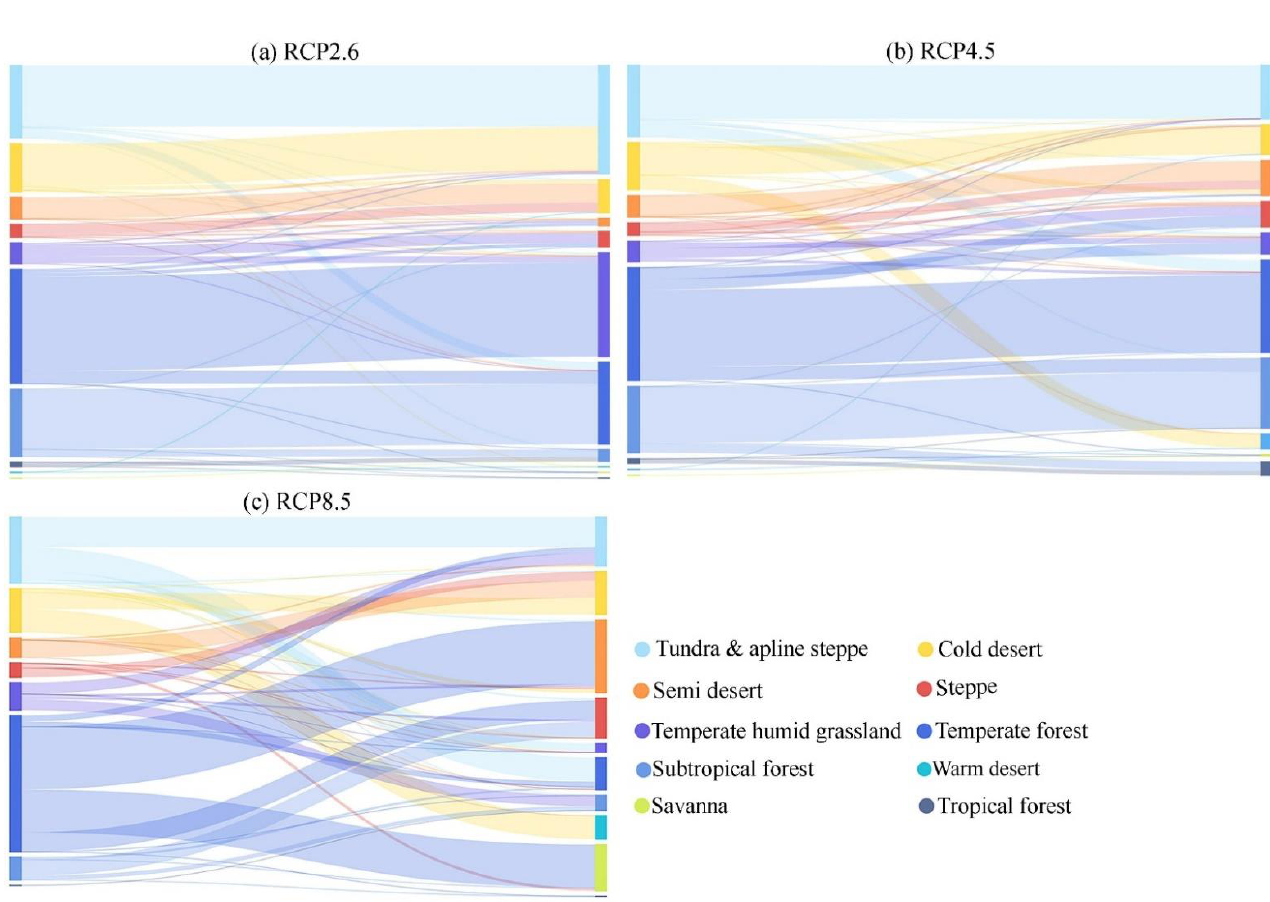
Figure 17. Sankey diagram for successions among PNV super-classes from 1970–2000 to 2080s under RCP2.6 ( a ), RCP4.5 ( b ), and RCP8.5 ( c ) climate scenarios, respectively.